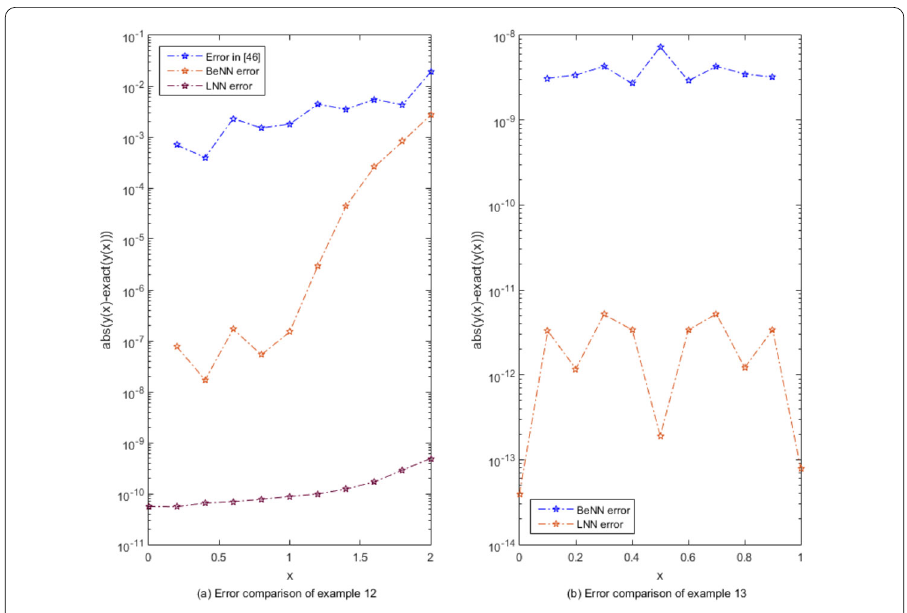
Figure 9 Error comparison of Examples 12 and